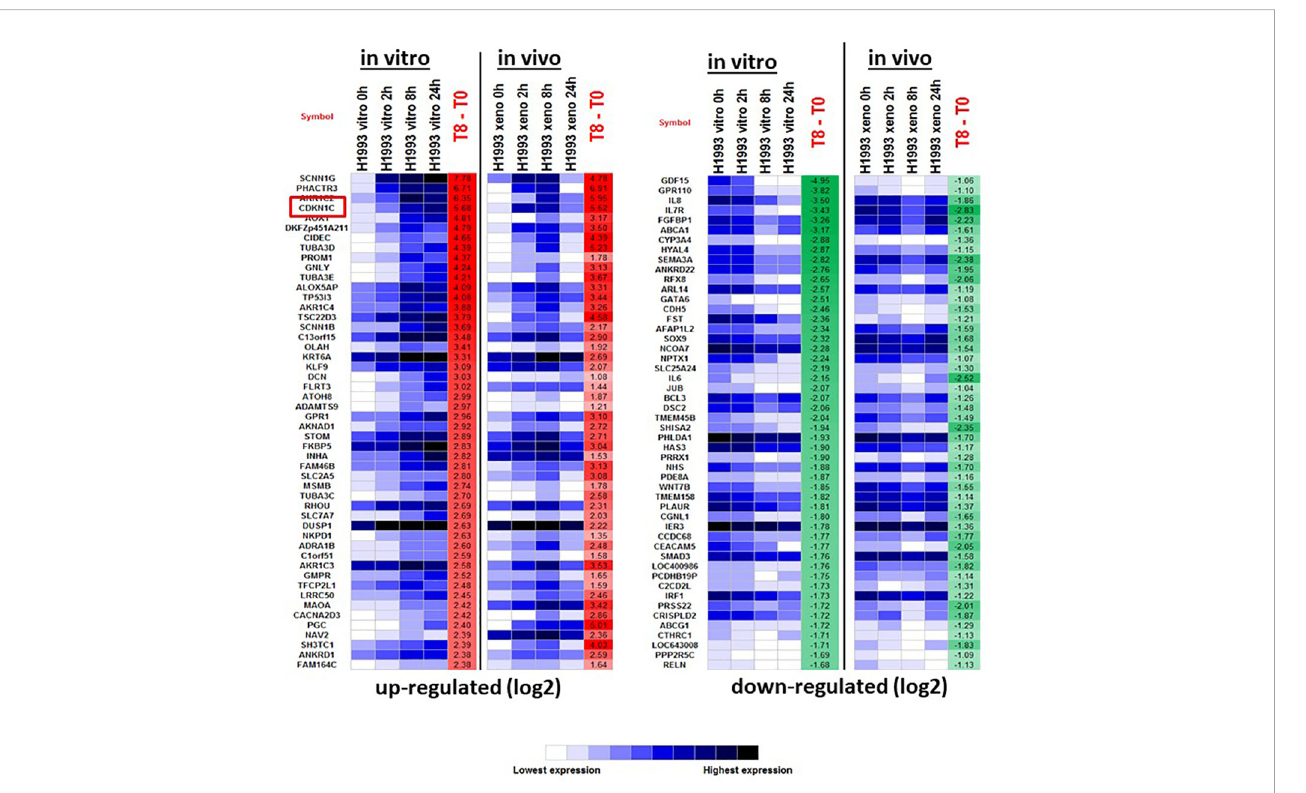
FIGURE 5 The top 50 up- and down-regulated genes in response to DEX in DEX-sensitive NCI-H1993 in vitro and in vivo (xenograft). CDKN1C is